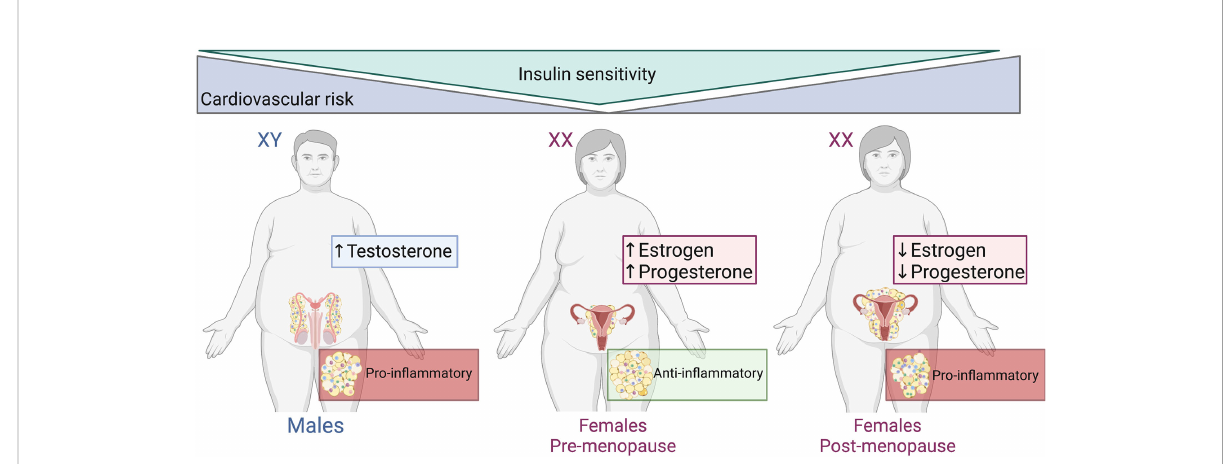
FIGURE 2 Adipose tissue distribution, sex hormones and metabolic disturbances of obesity. Males and post-menopausal females have increased cardiovascular risk, abdominal/visceral obesity and reduced insulin subcutaneous adipose distribution compared to pre-menopausal females. The adipose tissue within males and post-menopausal females is more pro-in fl ammatory than that of pre-menopausal females. Created with